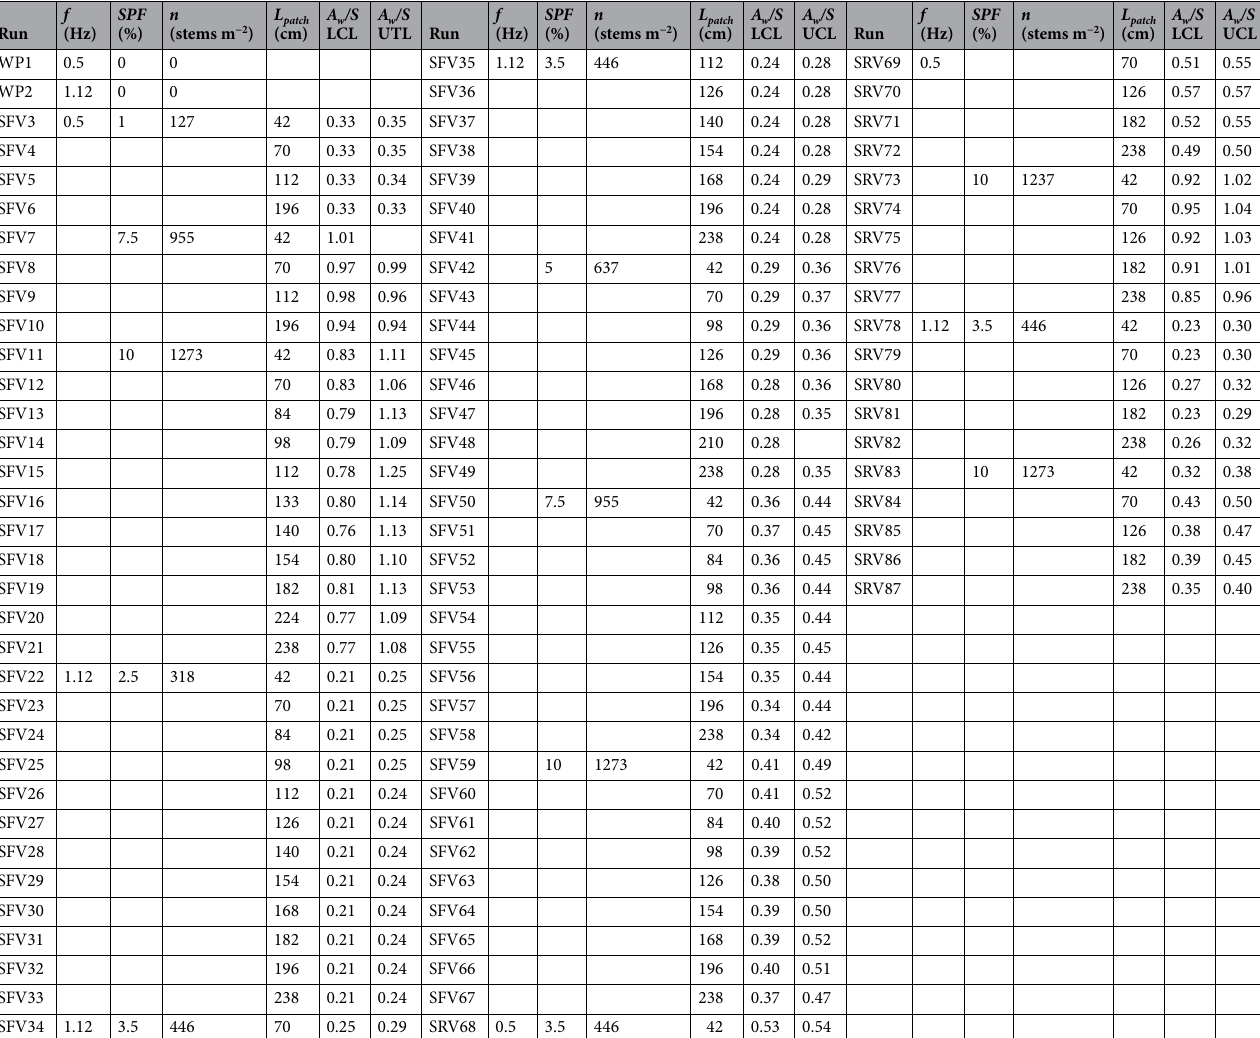
Table 2. Summary of the experimental conditions tested. Where SFV correspond to Submerged Flexible Vegetation and SRV to Submerged Rigid Vegetation. LCL denotes the lower canopy layer and UCL the upper canopy